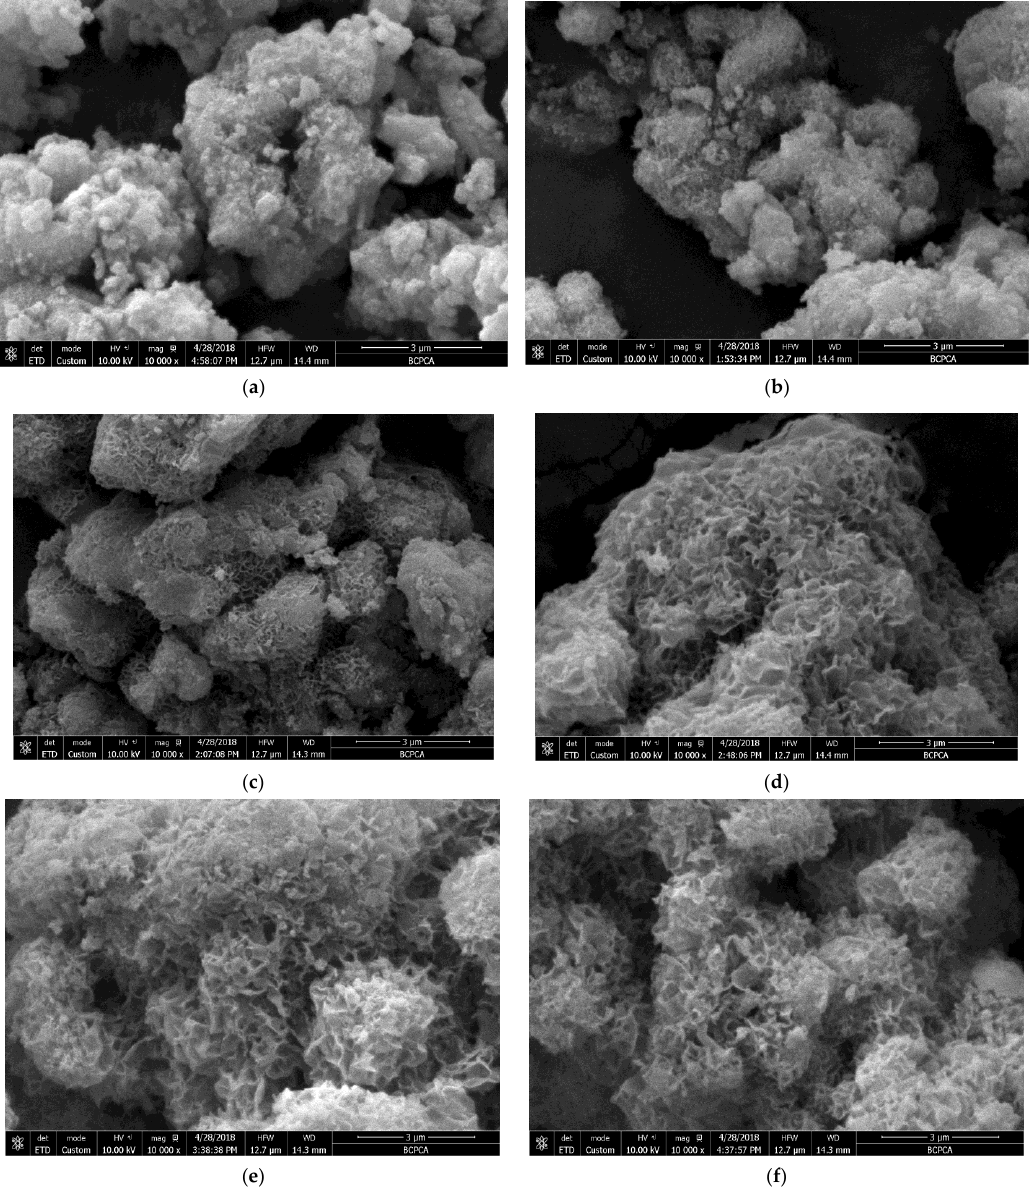
Figure 4. Micromorphology of the products at different temperatures: ( a ) 295 K; ( b ) 310 K; ( c ) 330 K; ( d ) 350 K; ( e ) 360 K; ( f ) 365 K.